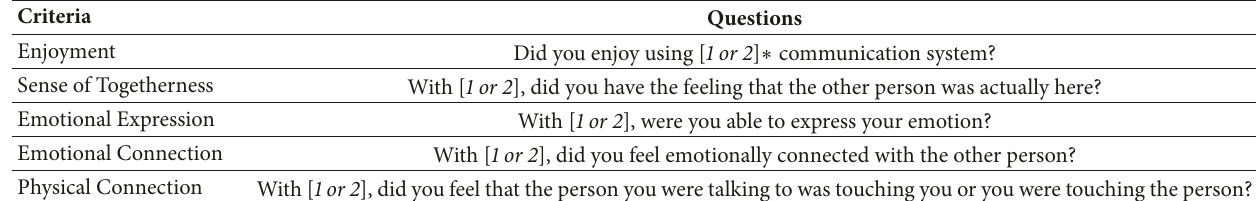
Table 3: Criteria for the assessment of the perceived communication